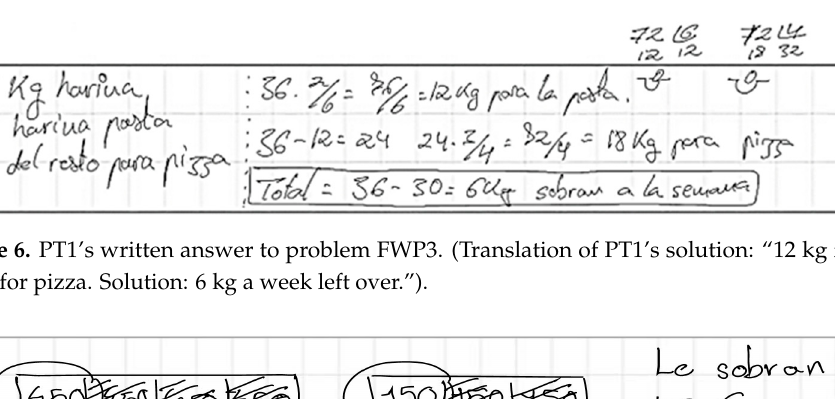
Figure 5. PT37’s written answer to problem FWP2. (Translation of PT37’s solution: “During the week 90 cans are sold. At the weekend 252 cans are sold. Solution: 378 cans remain unsold.”).